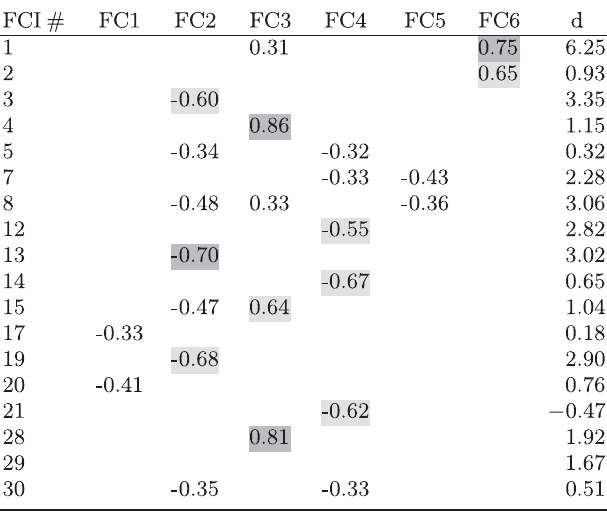
TABLE IV. Exploratory factor analysis for the reduced FCI (varimax rotation). Only loadings greater than 0.3 are shown. Loadings greater than 0.7 are highlighted in dark gray. Loadings between 0.5 and 0.7 are highlighted in light gray.